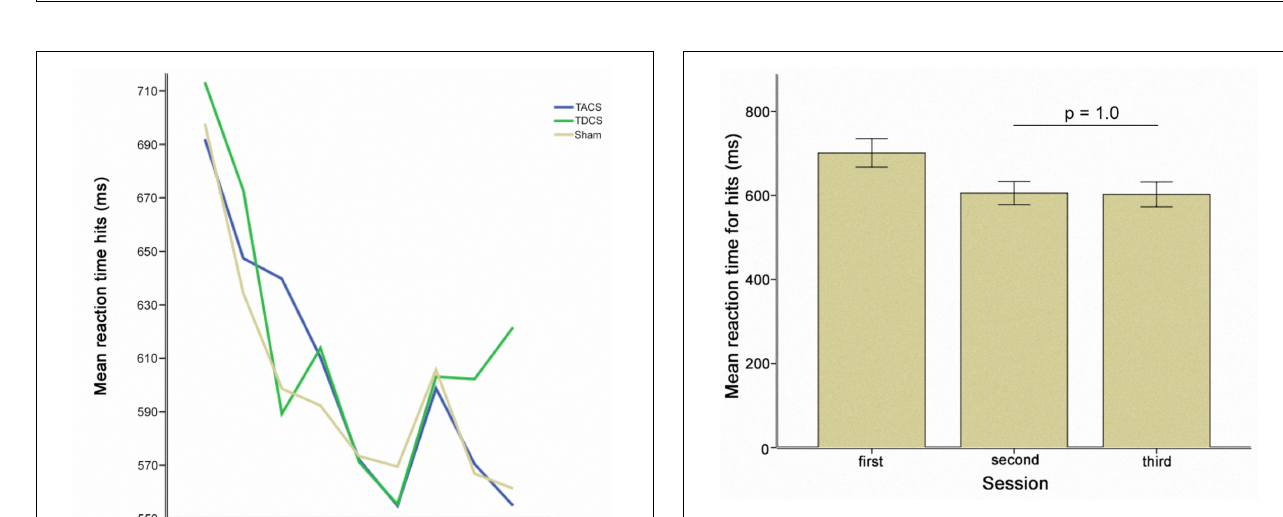
FIGURE 2 | Behavioral performance measured before, during, and after stimulation for each stimulation type. (A) Mean accuracy reflected in d (cid:48) values. (B) Mean reaction times for hits. Error bars represent one standard error of the mean.